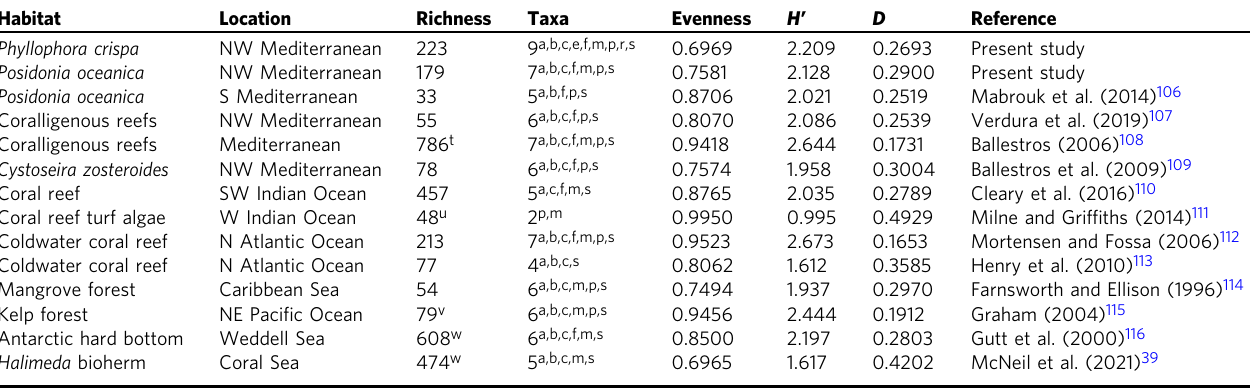
Indices and evenness presented here were calculated based on classical formulas and not based on Hill-number calculations to enable comparison with literature data (see Methods). a Ascidiacea, b Bryozoa, c Cnidaria, e Entoprocta, f Foraminifera, m Mollusca (Bivalvia), p Polychaeta (Sedentaria), r Rotifera, s Porifera. t Data collated from multiple other publications. u Excluded Cnidaria, Bryozoa and Ascidiacea from the analysis. v Respective study included barnacles and phoronids that were not included in the current analysis. w Excluded Polychaeta from the